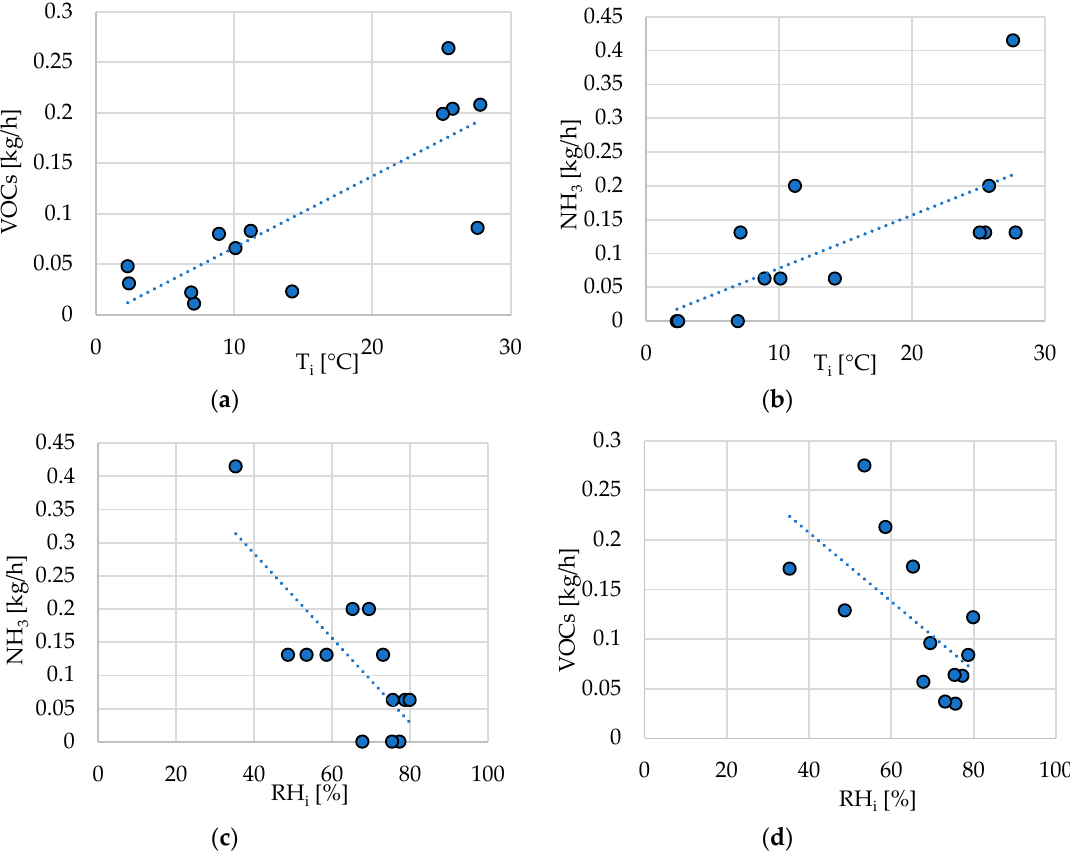
Figure 15. Correlation diagrams between emission from roof ventilators at biogas plant B and measured microclimatic parameters, with regression lines: ( a ) R 2 = 0.67, ( b ) R 2 = 0.47, ( c ) R 2 = 0.41, ( d ) R 2 = 0.58.